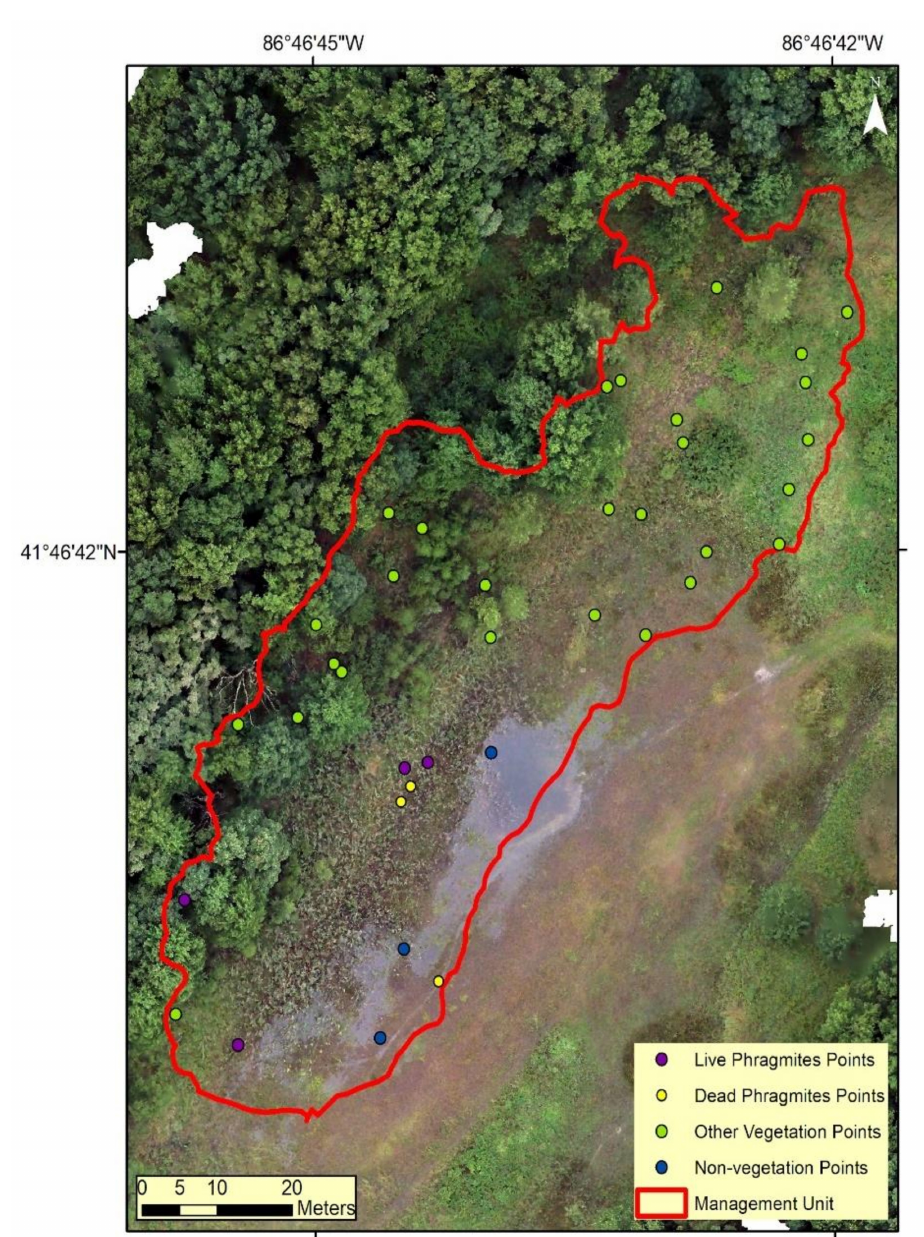
Figure 7. Placement of validation sample points for each of the four aggregated classes (live Phrag- mites , dead Phragmites , other vegetation, and non-vegetation) at Site 103 used for accuracy assessment following the method of Congalton and Green